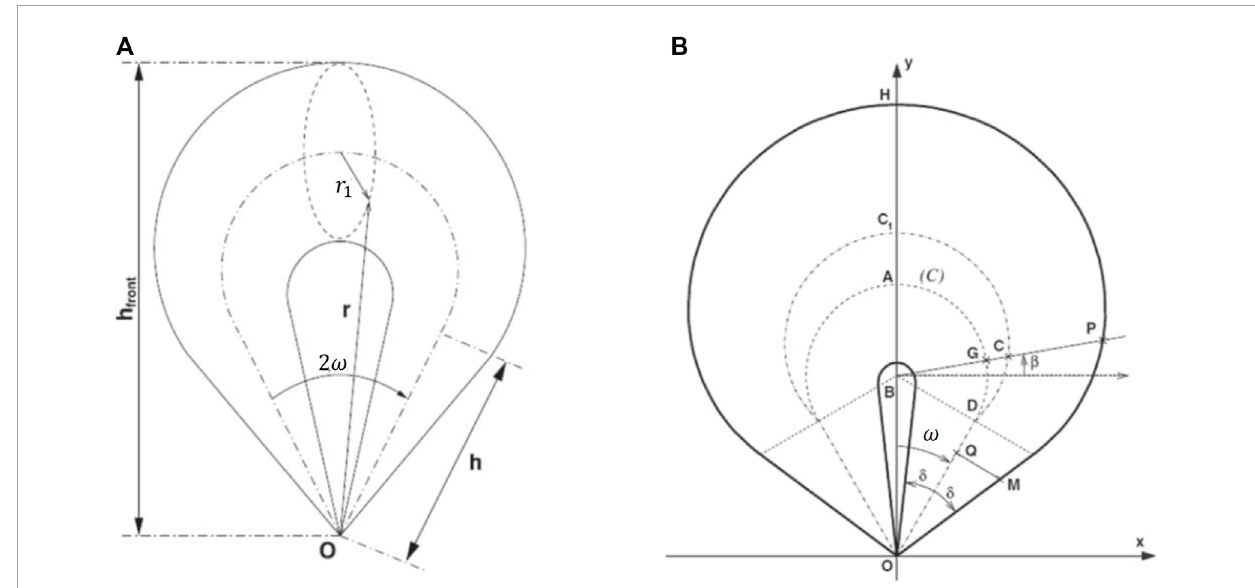
FIGURE 9 (A) Face-on schematic of the graduated cylindrical shell model (Thernisien et al., 2009), (B) Schematic of the detailed geometric parameter (Thernisien,